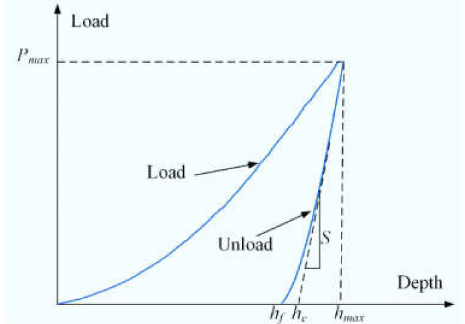
Figure 3. Schematic of the microhardness